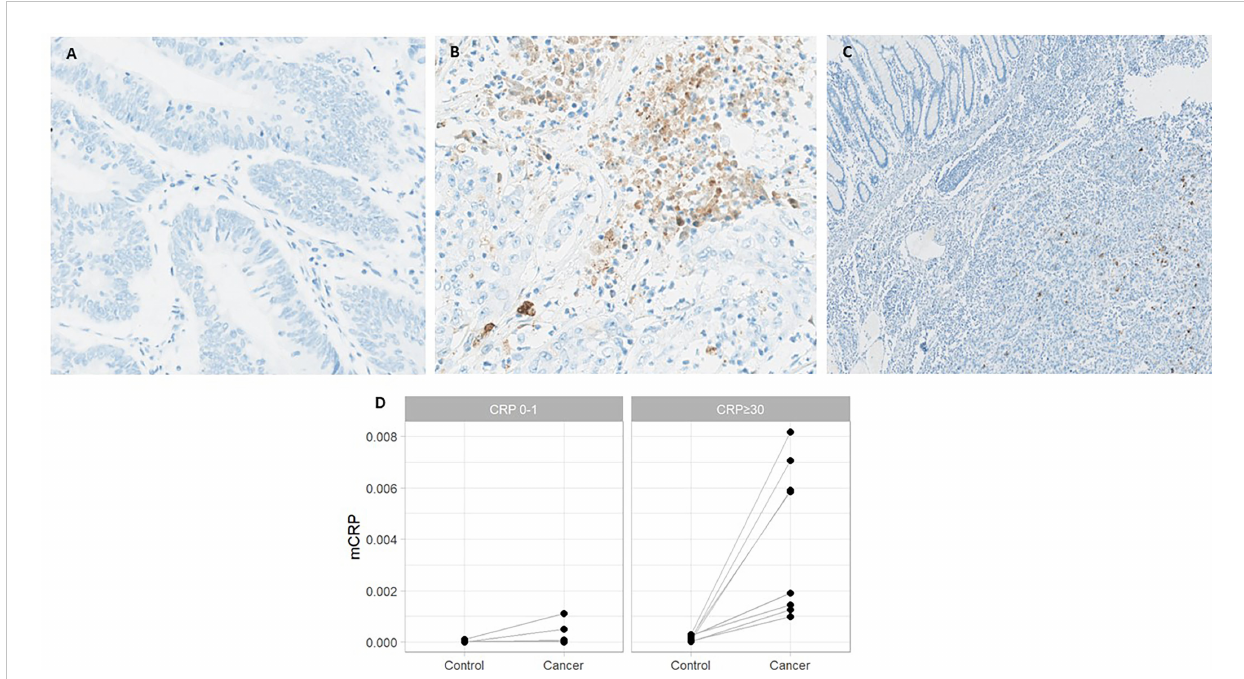
FIGURE 2 mCRP expression in systemically in fl amed and non-in fl amed colon cancer patients and adjacent normal colon mucosa. Representative images from patients with (A) normal and (B) elevated circulating CRP. (C) Normal colon mucosa adjacent to the tumor with no mCRP expression. (D) Quanti fi ed mCRP (proportion of area with positive mCRP staining) assessed within the tumor and adjacent normal colon mucosa (control) in CRP-high and CRP-low